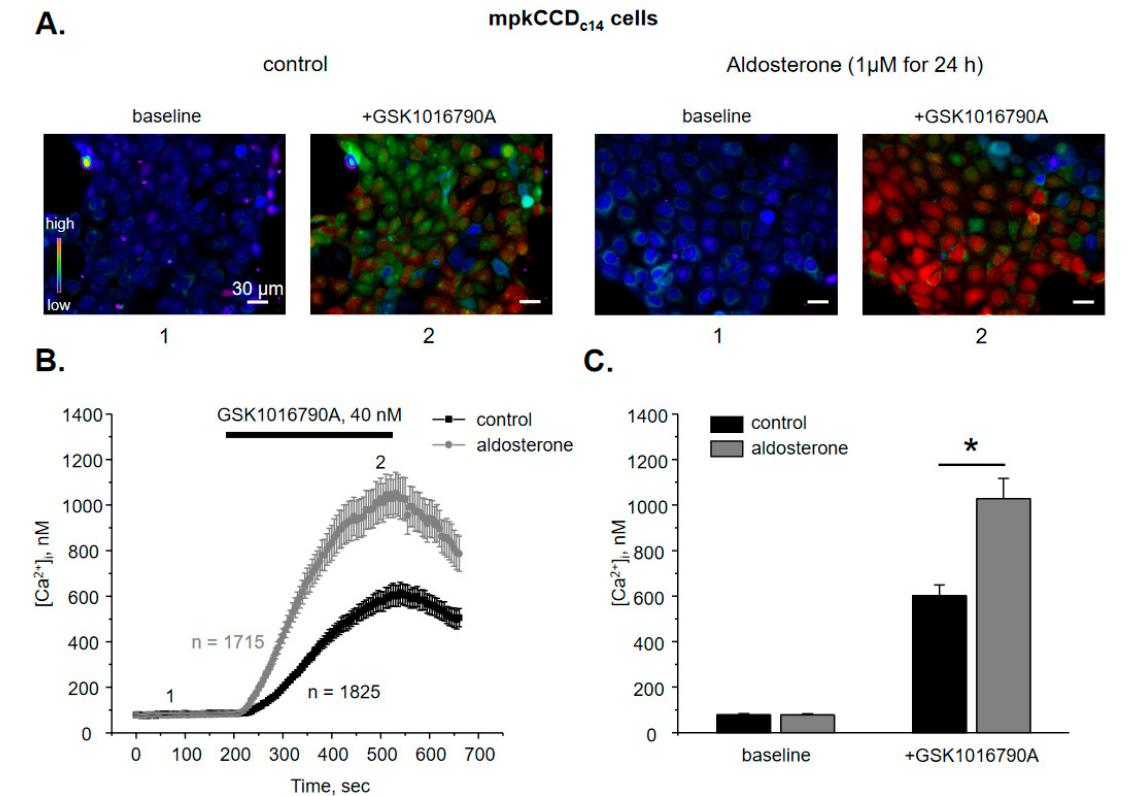
Figure 2. Aldosterone augments TRPV4-dependent Ca 2+ influx in mpkCCD c14 cells. ( A ) Representative pseudo-color images of [Ca 2+ ] i changes (blue—low and red—high) in confluent monolayers of mpkCCD c14 cells at the baseline (1) and following 5 min application of TRPV4 agonist, GSK1016790A (2) maintained on standard (control) conditions and following 24 h treatment with aldosterone. ( B ) The averaged time-courses of [Ca 2+ ] i changes in individual mpkCCD c14 cells in the control and after incubation with aldosterone upon application of 40 nM GSK1016790A (shown with the bar on top). The time-points 1 (baseline) and 2 (GSK1016790A) represent conditions shown in panel (A). ( C ) Summary graph comparing [Ca 2+ ] i values in individual mpkCCD c14 cells in the control and following aldosterone treatment at the baseline and after GSK1016790A application. *—significant difference ( p < 0.05) between groups is indicated with a